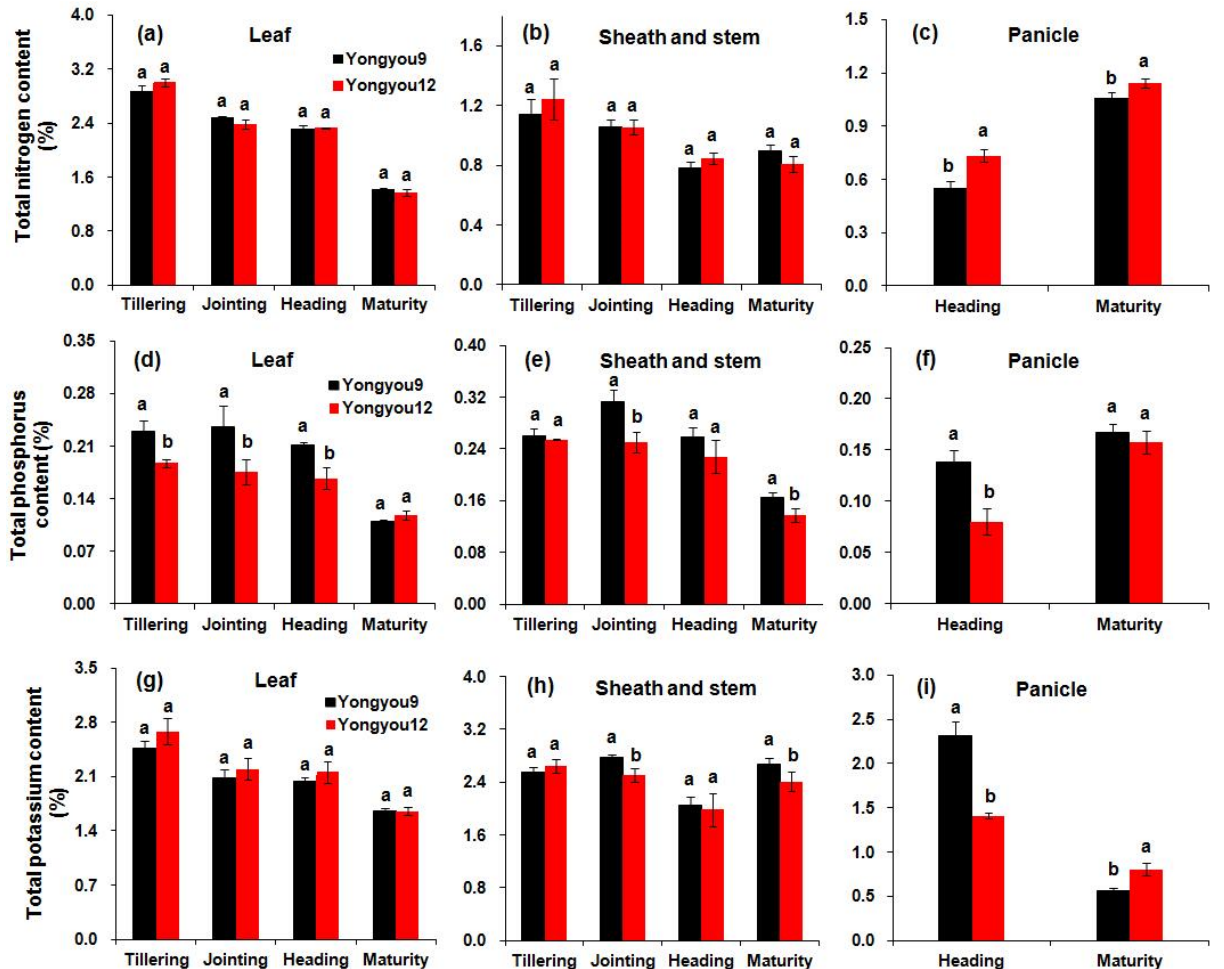
Figure 12. Changes in the contents of nitrogen ( a – c ), phosphorus ( d – f ), and potassium ( g – i ) in rice leaves, stems and sheaths, and panicles. Error bars denote ± standard deviation ( n = 3). Different letters indicate a significant difference at the 0.05 probability level.